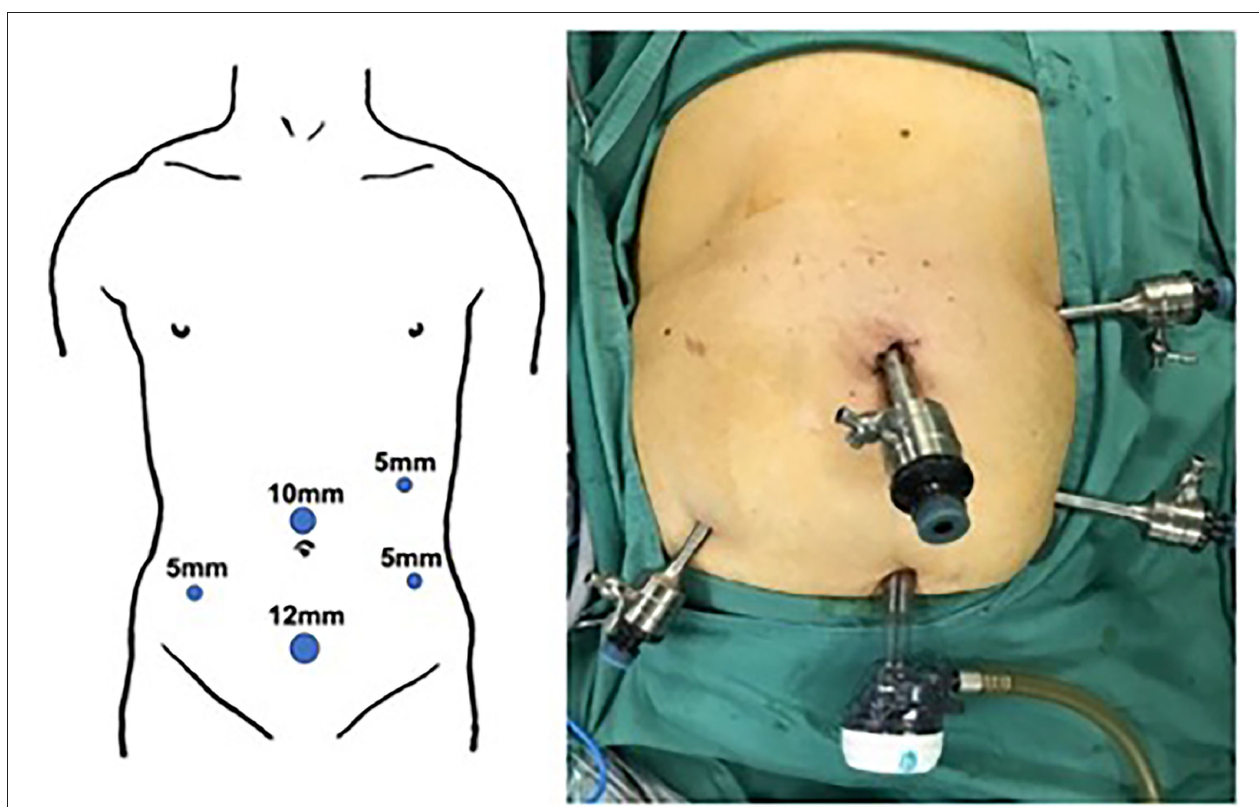
FIGURE 1 | Illustrative photo of 5